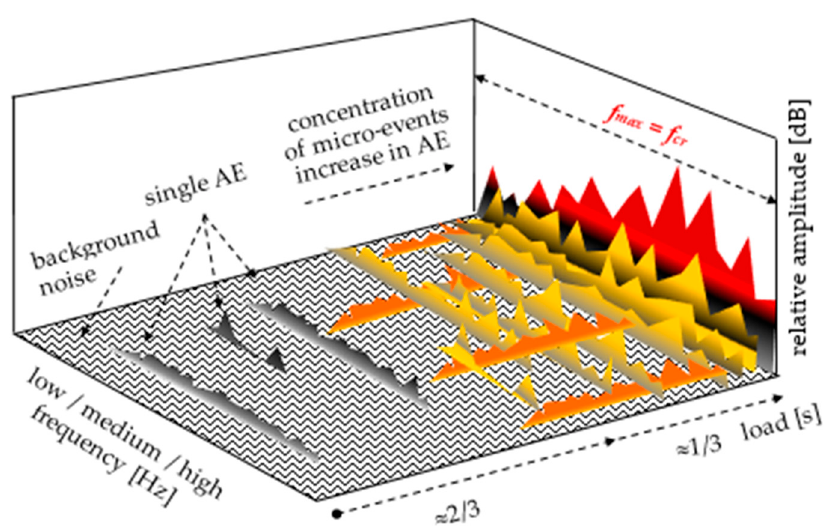
Figure 7. The range of micro-events in cement composites (f cr = f max ) identified by means of a space sound spectrum.